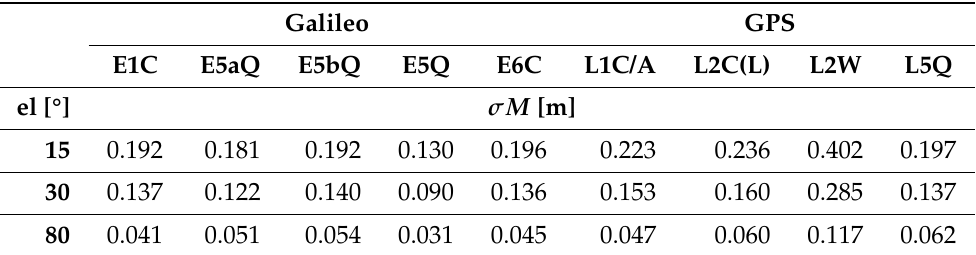
Table 2. Standard deviation of the code multipath error for a specified elevation estimated on the basis of the model.